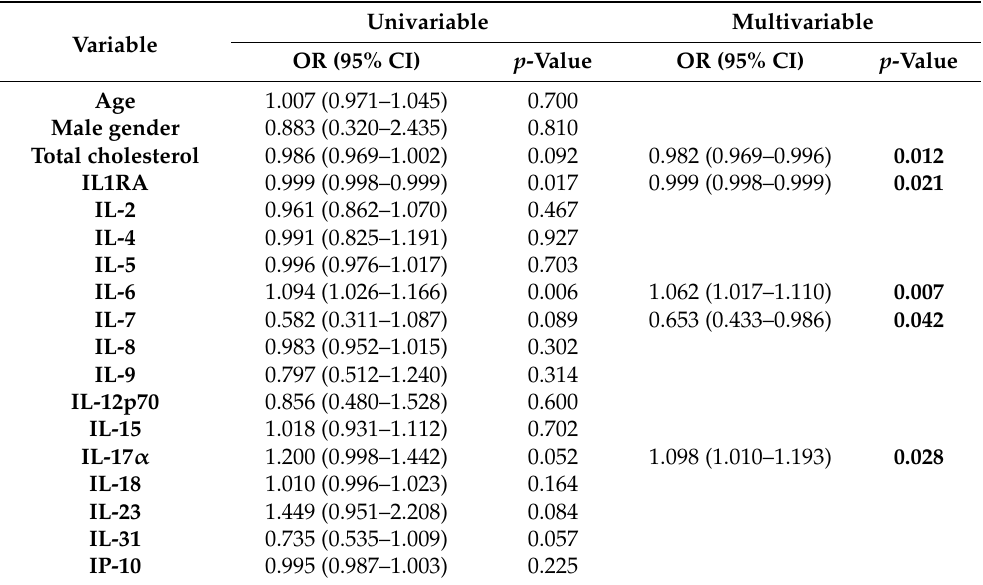
Table 2. Univariable and multivariable logistic regression analysis of lipid peroxidation at the time of hospital